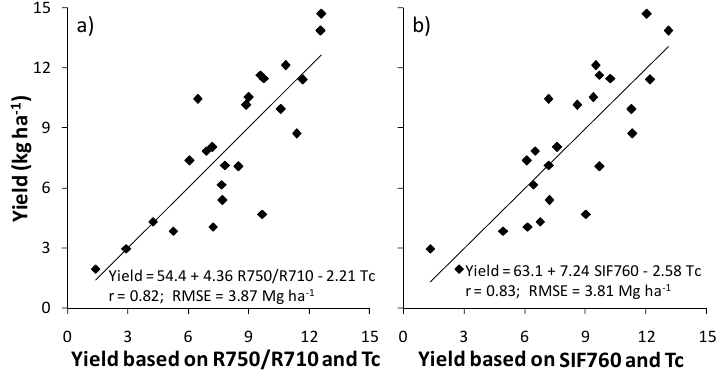
Figure 7. Maize yield observed versus the estimated yield based on a linear correlation of canopy temperature (Tc) and either R750/R710 ( a ) or SIF760 ( b